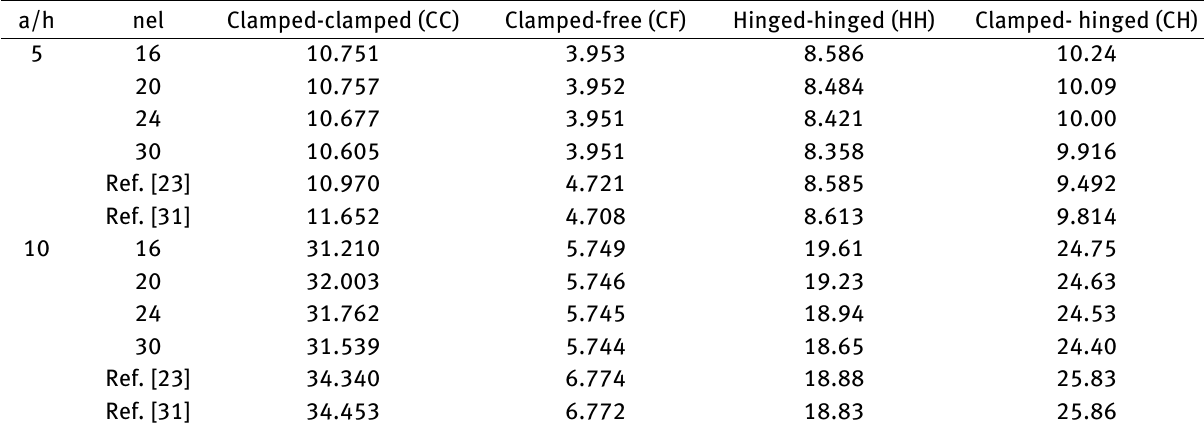
Table 1: Convergence study for laminated composite beam under different boundary conditions a/h nel Clamped-clamped (CC) Clamped-free (CF) Hinged-hinged (HH) Clamped- hinged